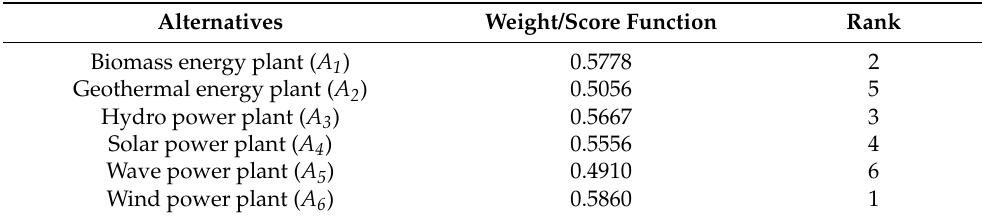
Table 16. The score function and rank for each alternative adopted from Deli et al. [30].